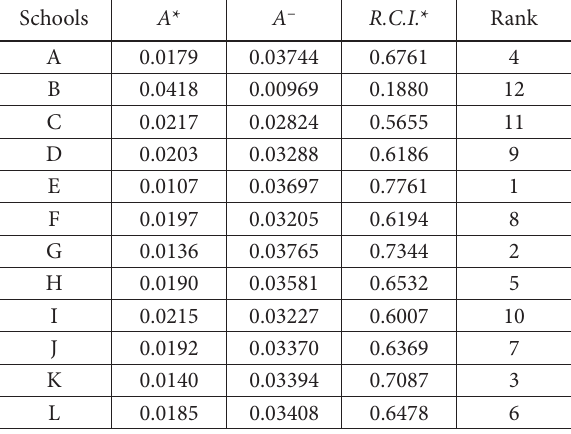
Table 9. A *, A − and R.C.I. *